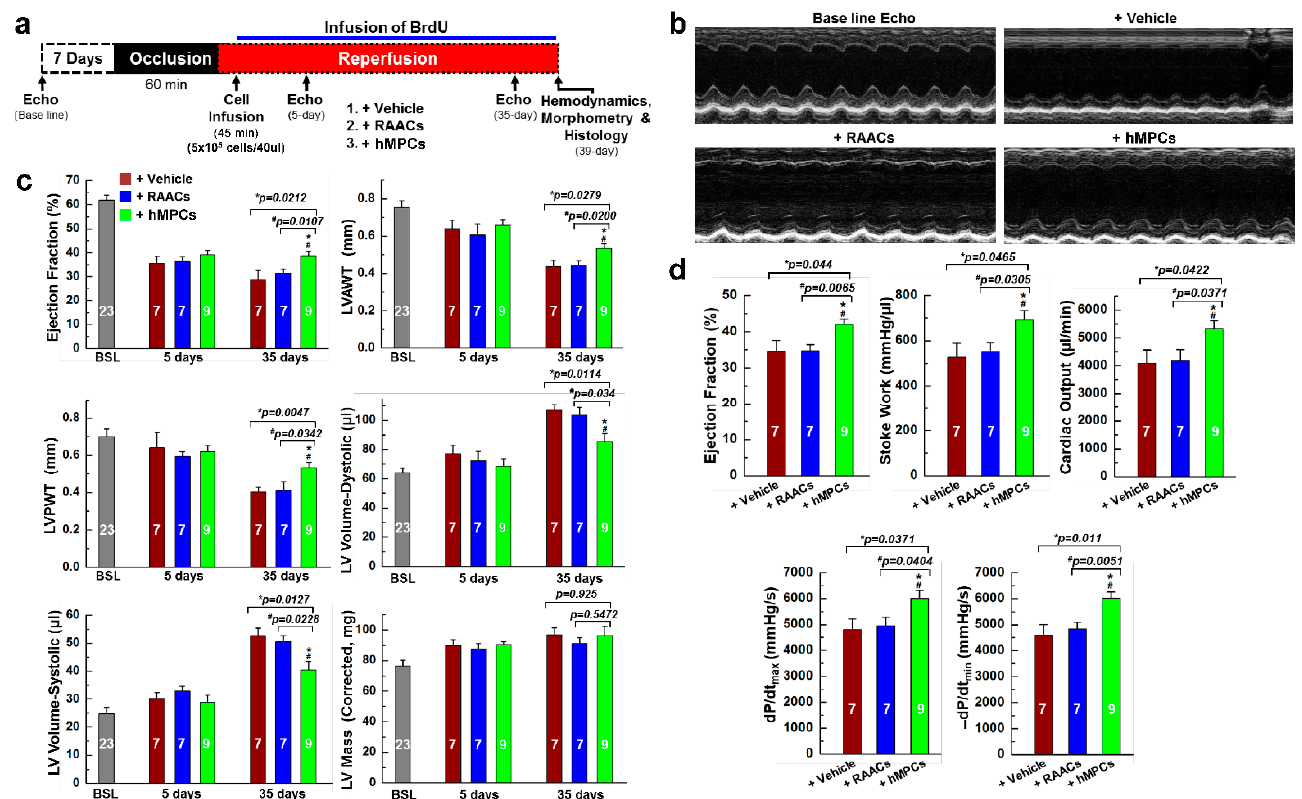
Figure 4. Transplantation of hMPCs into infarcted mouse heart improves cardiac function and structure. ( a ) Schematic protocol for the murine model of acute myocardial infarction and cellular therapy. ( b ) Representative images of M-mode echocardiograms (Echo) at the baseline and